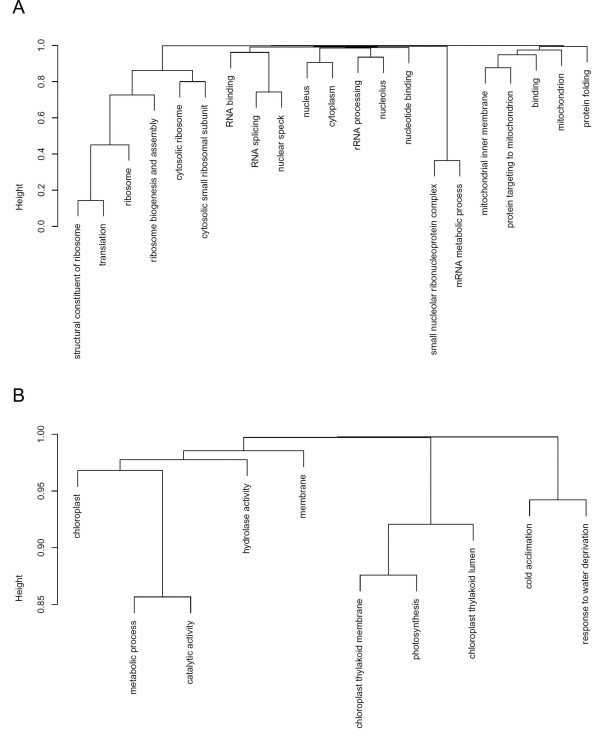
Gene sets enriched among transcripts differentially expressed in AtGRP7-ox. PAGE [39] was used to calculate the Z score for predefined gene sets from the signal log ratio between wt and AtGRP7-ox plants and to infer statistical significance against standard normal distribution. A) Agglomerative clustering of groups of genes expressed at a higher level in AtGRP7-ox plants. B) Agglomerative clustering of groups of genes expressed at a reduced level in AtGRP7-ox plants.